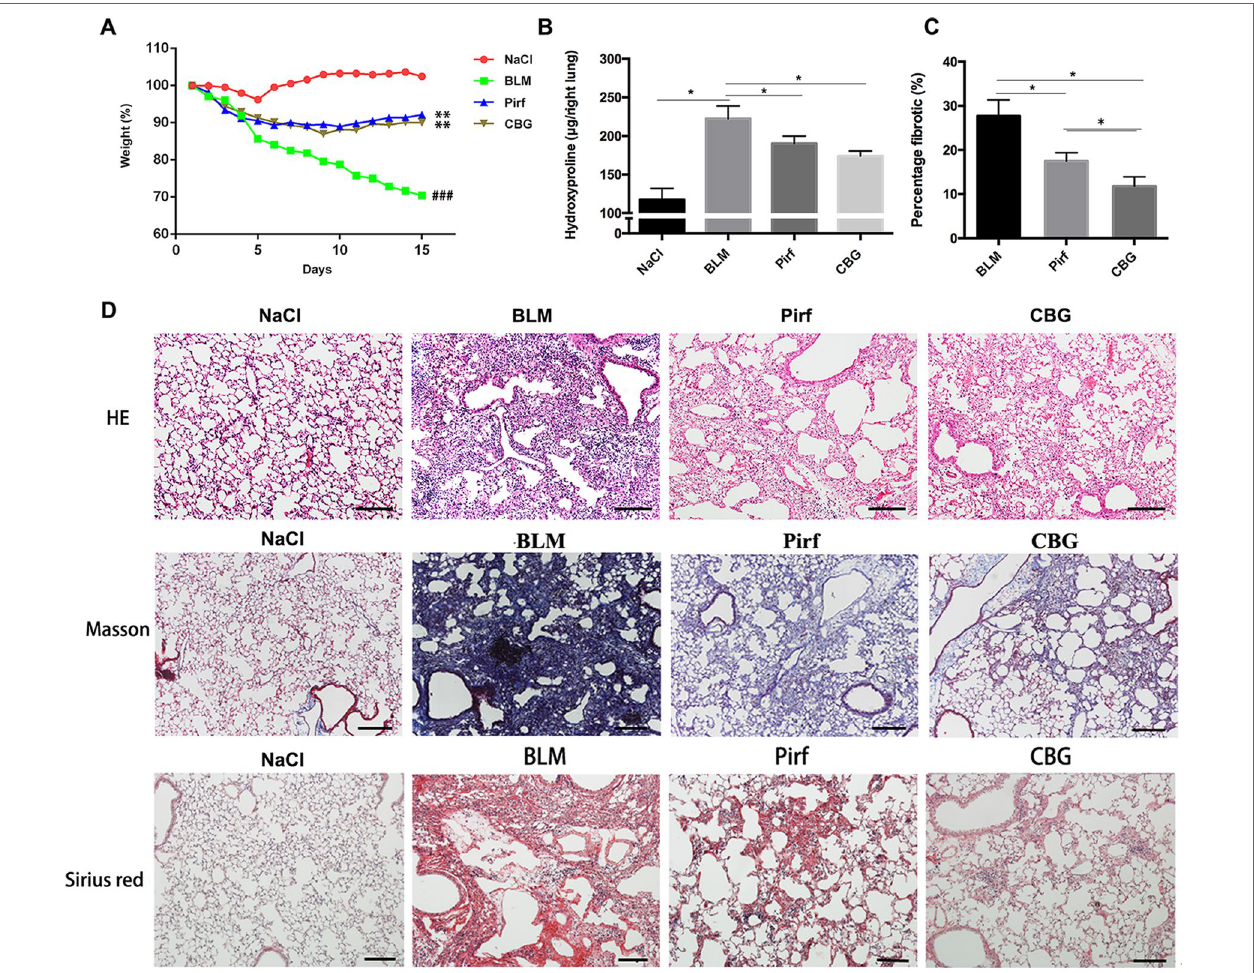
FIGURE 5 | Cinobufagin attenuates BLM-induced pulmonary fibrosis in mice. Mice were intratracheally injected with a single dose of BLM (2 mg·kg −1 ). Cinobufagin (10 mg·kg −1 ) and Pirfenidone (200 mg·kg −1 ) were given from day 7 to day 14 (n = 6 per group). (A) Average body weight of mice in each group. (B) Determination of hydroxyproline content in lung tissues of each group. (C) Statistics of pulmonary fibrosis area in each group. (D) Photomicrographs of lung sections stained with hematoxylin–eosin (HE), Masson Trichrome staining and Sirius red staining. Data are presented as the means ± SD (n = 6), # represents a comparison with the NaCl control group, * represents a comparison with the BLM group. ### P < 0.001; *P < 0.05; **P <